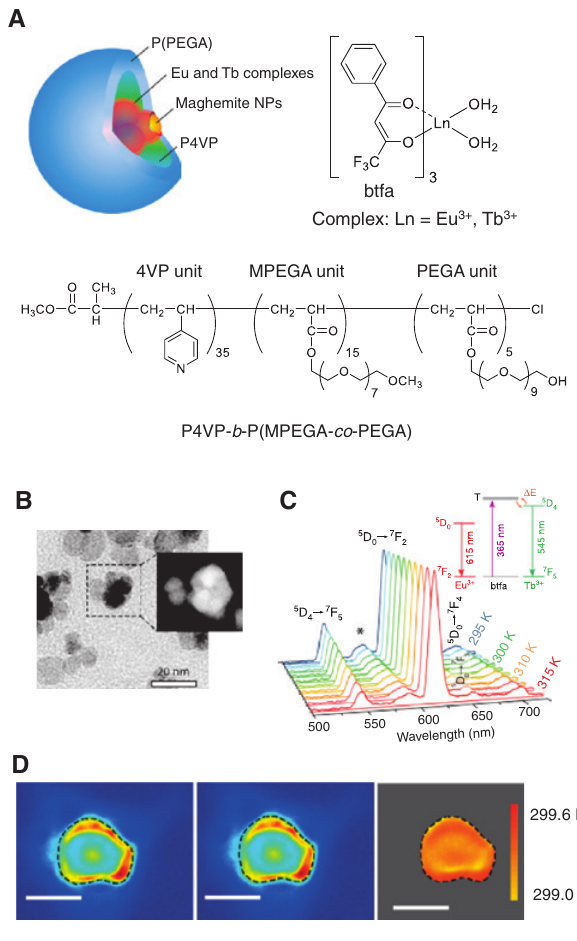
Figure 15: Intracellular temperature mapping of OK cells using magh- emite multiparticle core-shell beads.